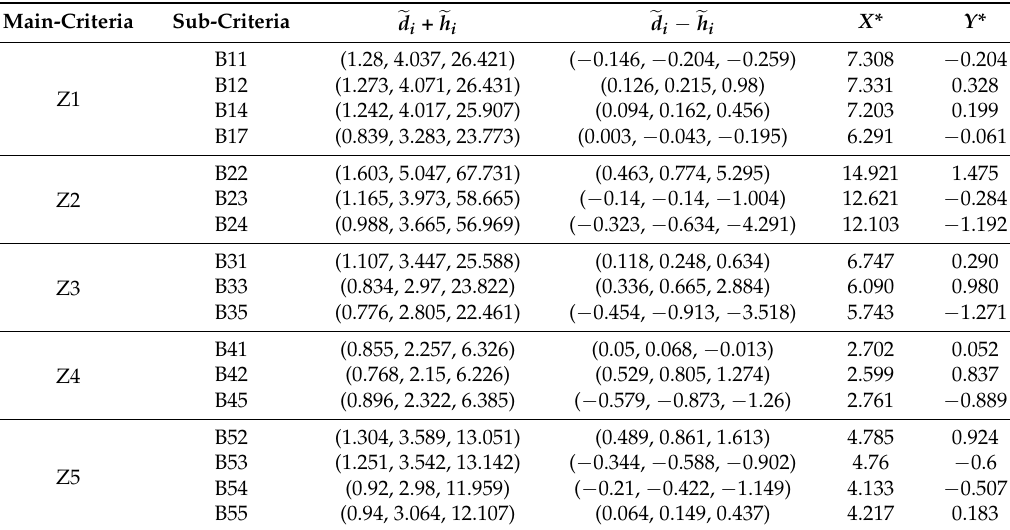
Table 12. The values of vector d + h , d − h , X* and Y* for the